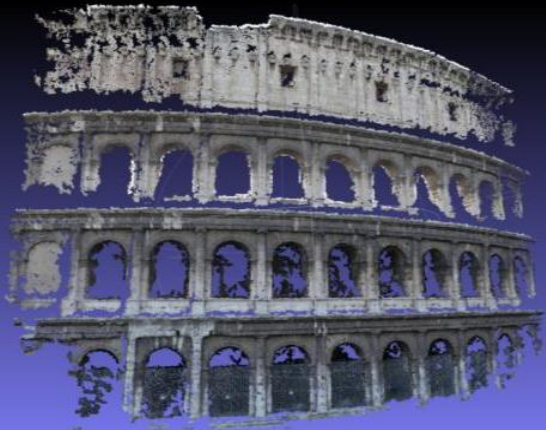
Figure 12. Automatic restitution of 3D points by SfM